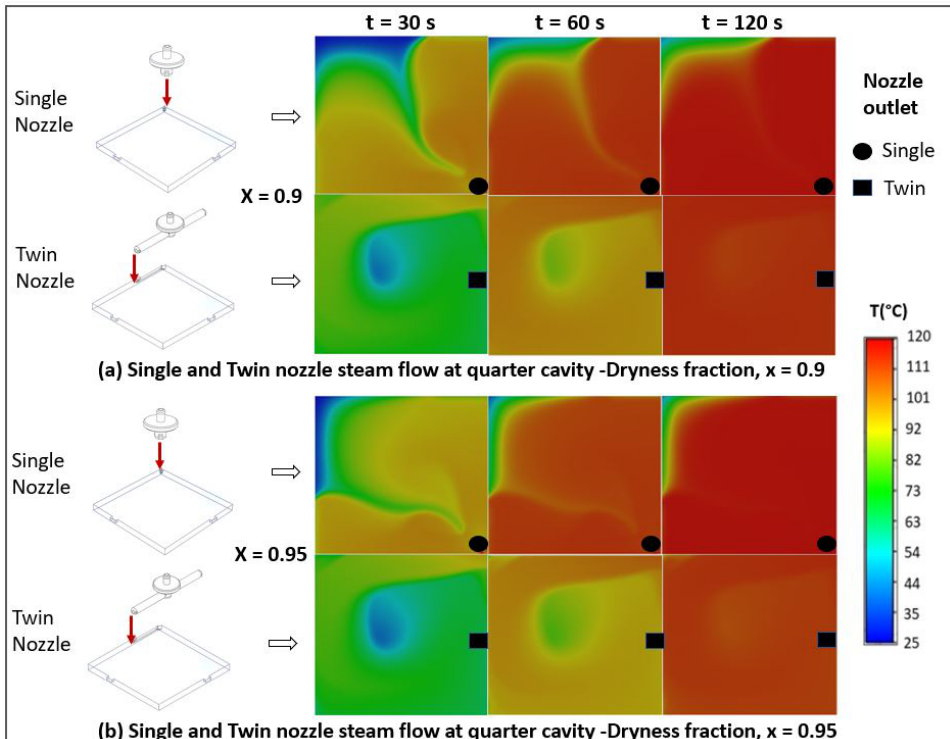
Figure 8. Top view of simulated temperature distribution at the mop–cavity